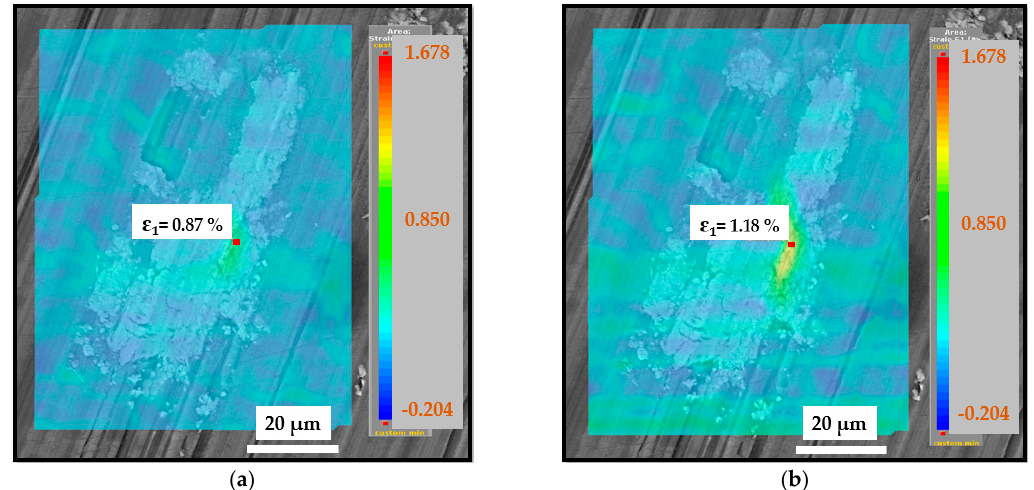
Figure 23. Engineering strain distribution ( a ) at 100 cycles; ( b ) at 500 cycles.